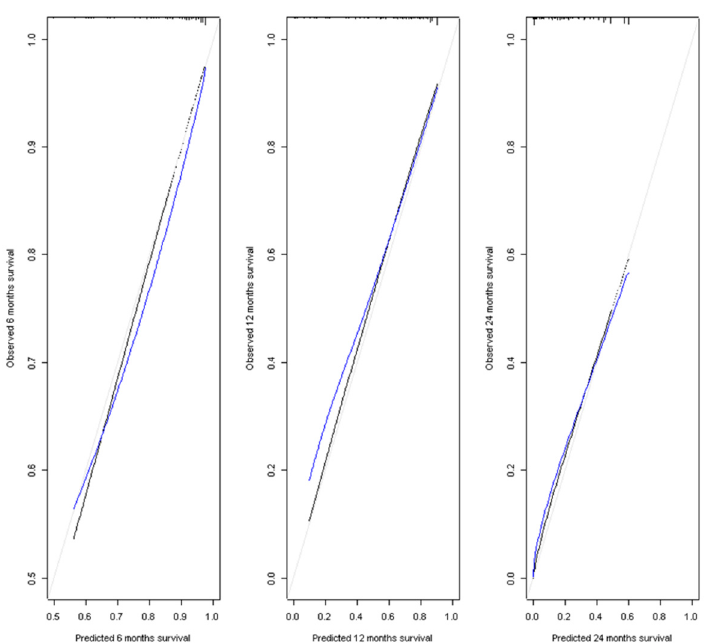
Figure 1. Nomogram of the final prognostic model. The sum of the prognostic factor points corresponds to the survival probability at 6, 12, and 24 months. On the nomogram, the first row corresponds to the row of points for the score of each variable. Next, we divided the prognostic factors into classes. The next line is the total score on which to sum the scores of the 4 variables in the nomogram. The last three lines correspond to the predicted survival at the 3 time points.